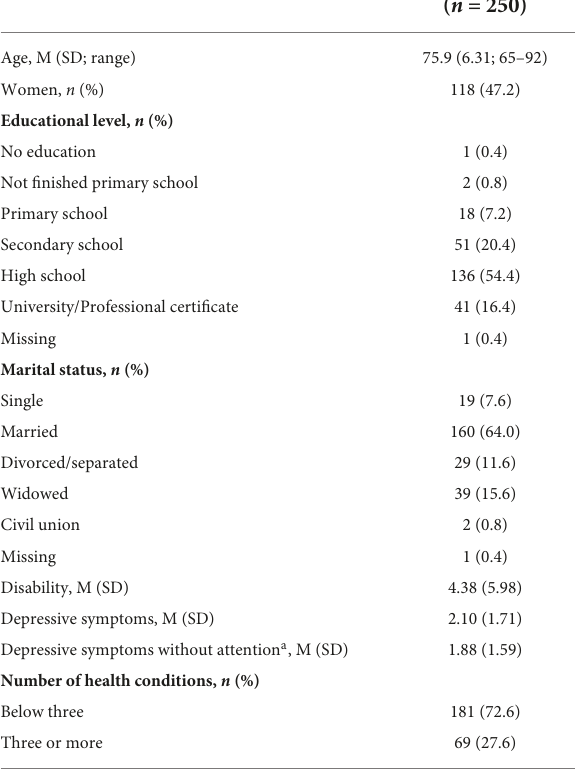
TABLE 1 Descriptive characteristics of the study